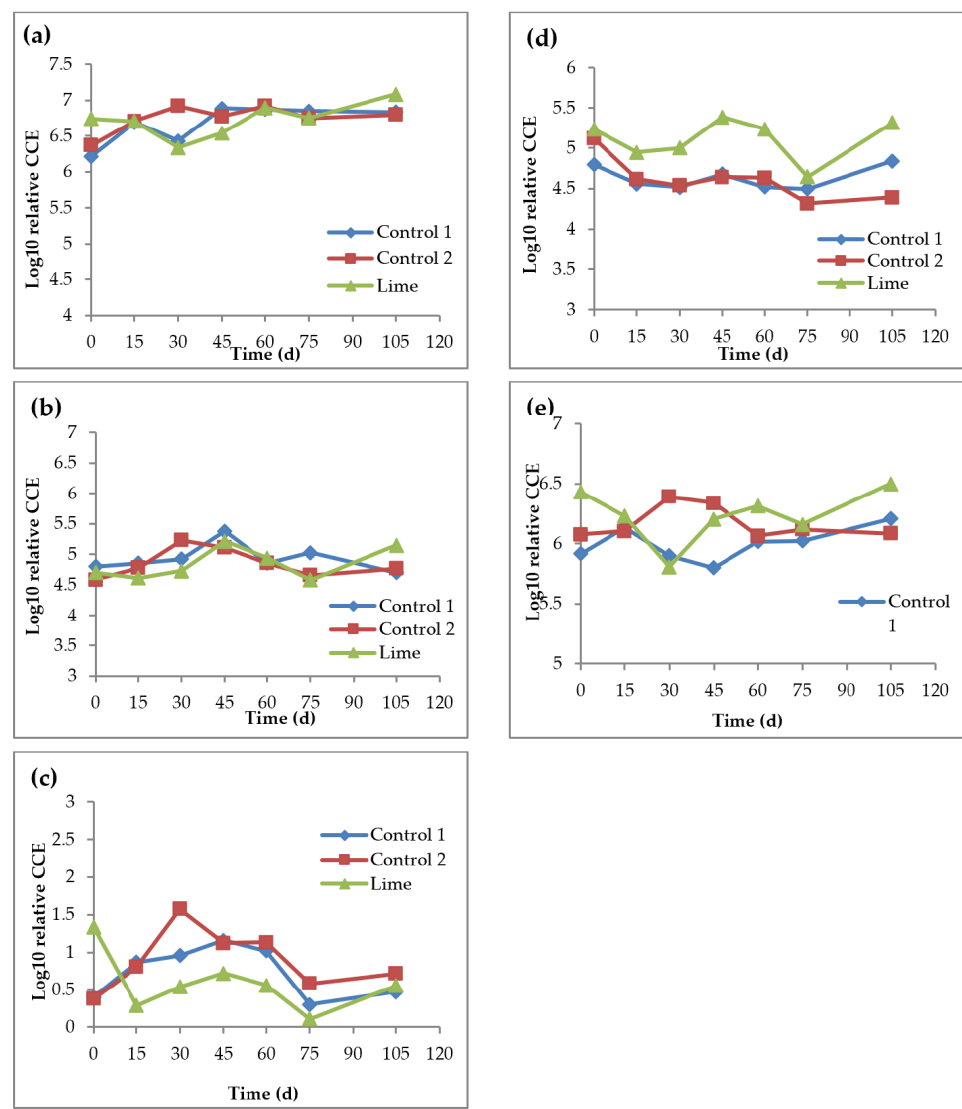
Figure 6. Relative change in CCE for Acidobacteria ( a ), Actinobacteria ( b ), Bacteroidetes ( c ), Firmicutes ( d ) and Proteobacteria ( e ). Control 1 is the soil reactor that received untreated sludge with no nanoparticles, control 2 is the soil reactor that received untreated sludge with 2 mg AgNPs/g TS sludge, and lime is the soil reactor that received lime treated sludge with 2 mg AgNPs/g TS sludge. The CCE trends over time for Acidobacteria were similar in control 2 and lime re- actors, and ANOVA showed no major differences in the CCE of Acidobacteria in all soil reactors ( p -value >0.05). This indicates that Acidobacteria was not adversely affected by the presence of AgNPs or the sludge lime treatment; CCE increased by 10%, 6% and 5% for control 1, control 2 and lime soil reactors, respectively. This is likely due to the potential of Acidobacteria to tolerate various pollutants and heavy metals [39–41]. Acidobacteria is also responsible for several beneficial soil fertility functions, including nitrate and nitrite reduction